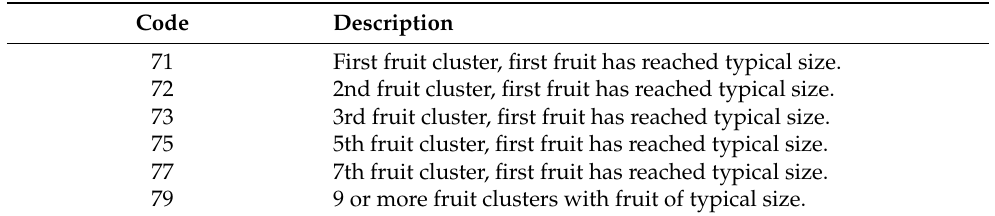
Table 6. Description of principal stage 7 (development of fruit) of slender nightshade, based on the BBCH scale.